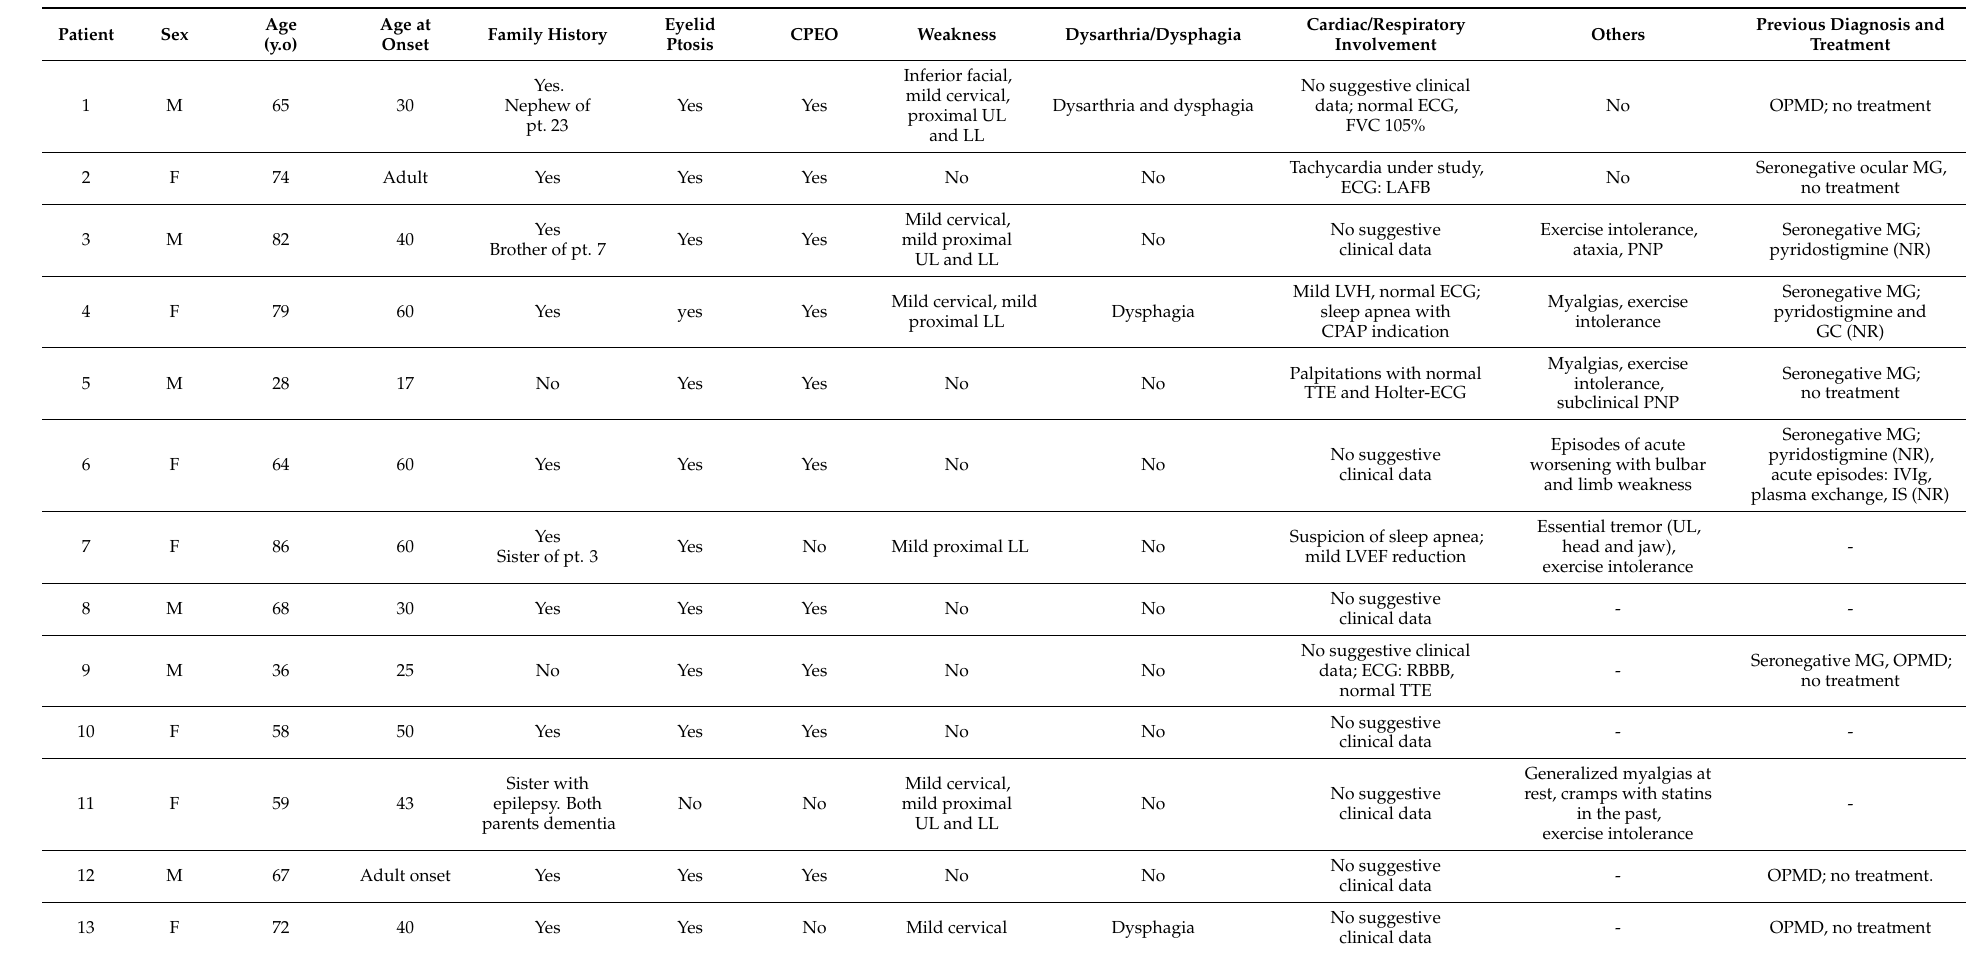
Table 1. Clinical features of patients with autosomal dominant progressive external ophthalmoplegia and TWNK